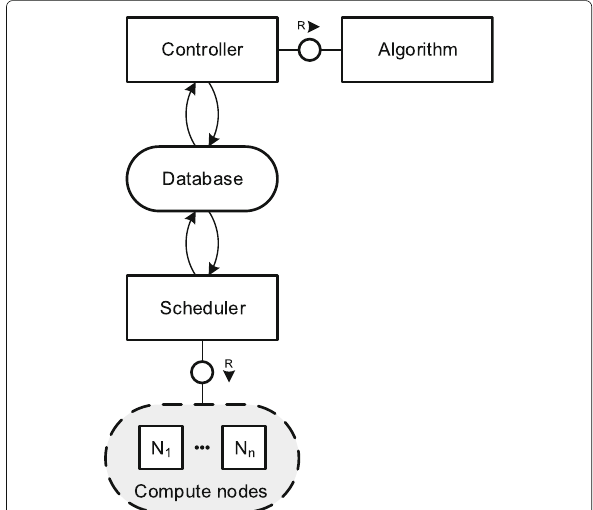
Fig. 11 The main components of our software architecture